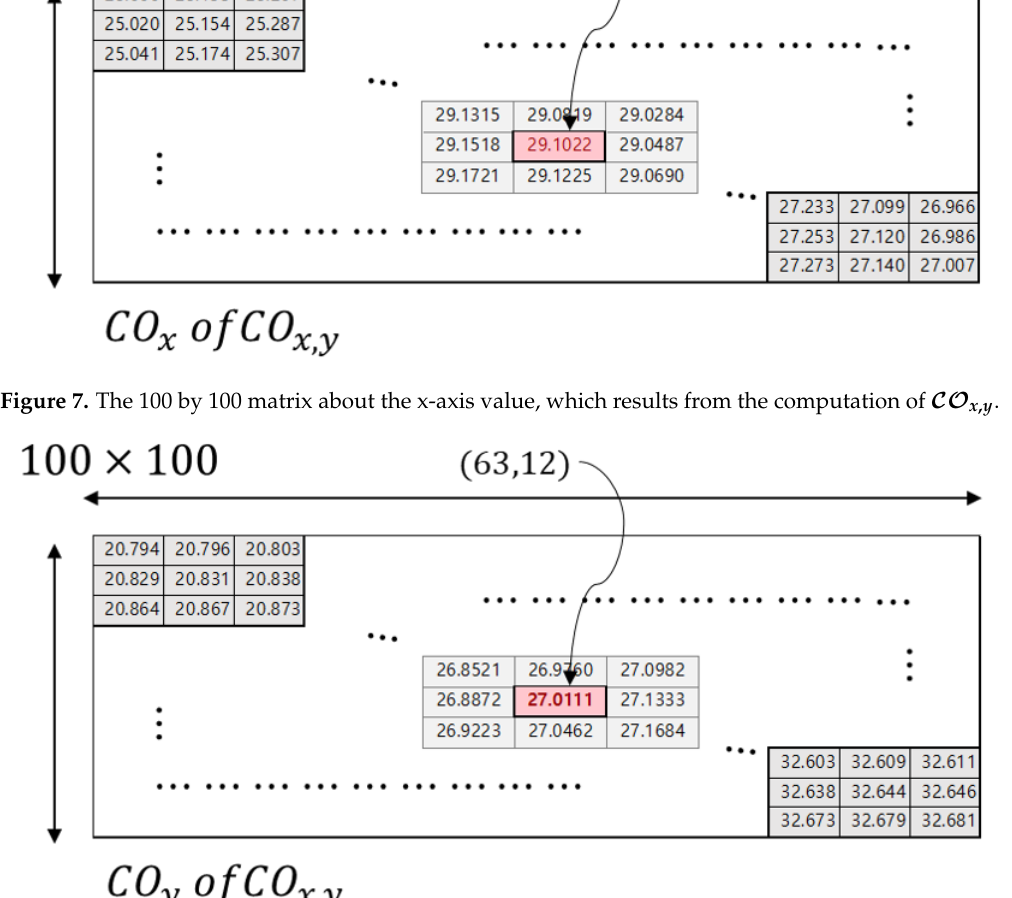
Figure 8. The 100 by 100 matrix about the y-axis value, which results from the computation of CO x , y .